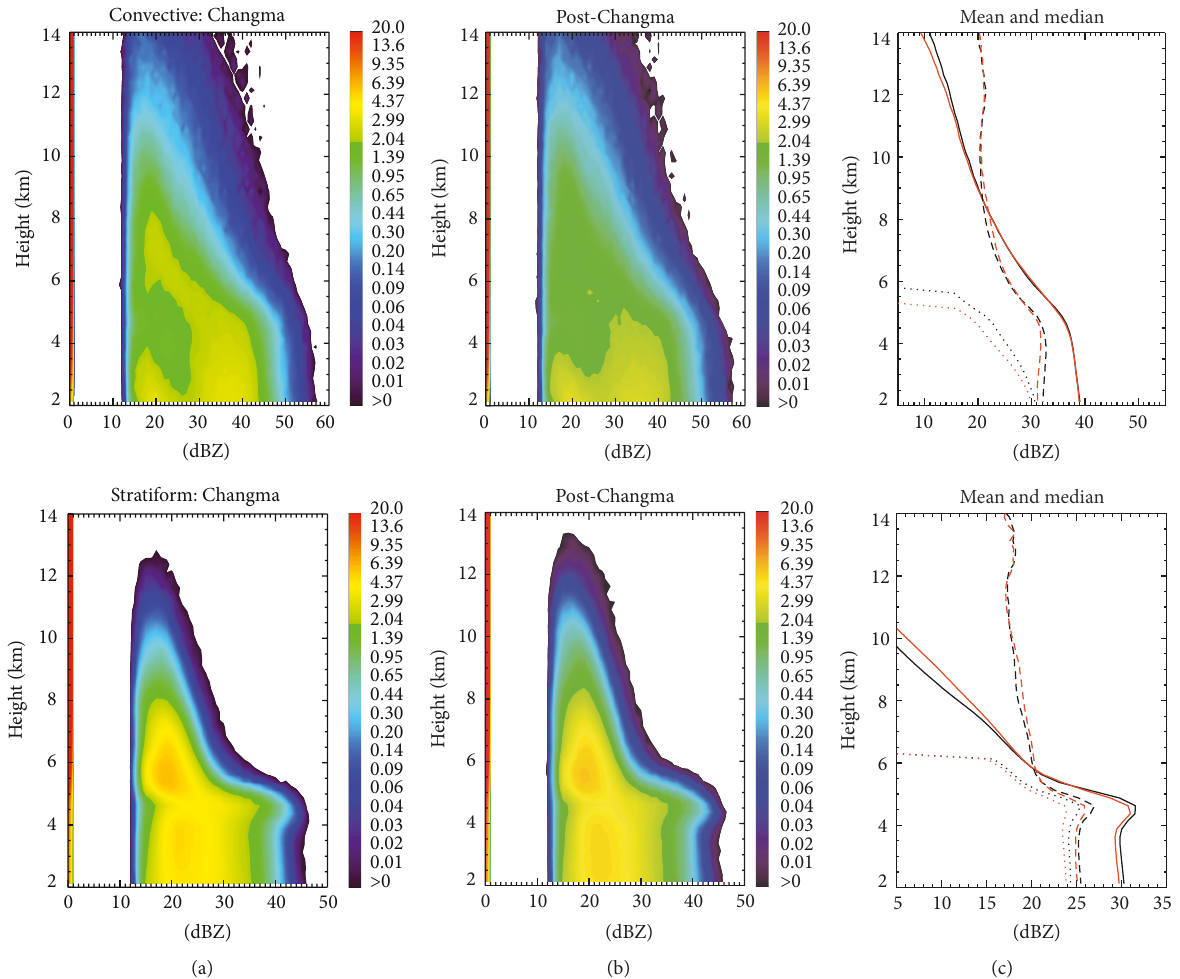
Figure 3: CFADs of the radar reflectivity profiles observed by PR (a, b) and mean radar reflectivity profiles (solid lines), median radar reflectivity profiles (dotted lines), and median profiles for radar reflectivities greater than the minimum detectable dBZ (dashed lines) (c). Black and red lines represent Changma and post-Changma period, respectively. The first and second rows represent convective and stratiform rain types,